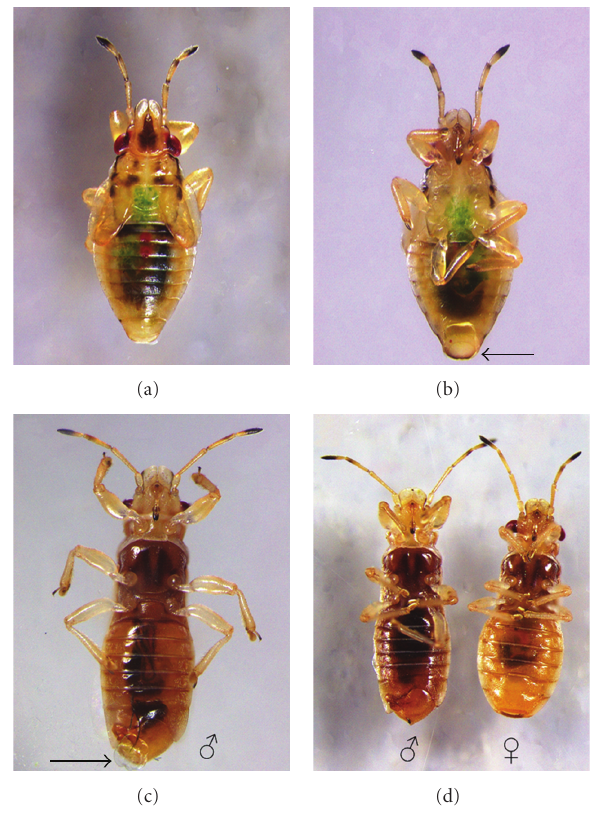
Figure 1: Thaumastocoris peregrinus (Heteroptera: Thaumastocori- dae) male, female, and nymph. (a) Dorsal view of a 5th-instar nymph; (b) nymphal ventral view showing the rectal organ (arrow); (c) ventral view of the male showing the everted rectal organ (arrow); (d) male and female ventral view with the rectal organ not